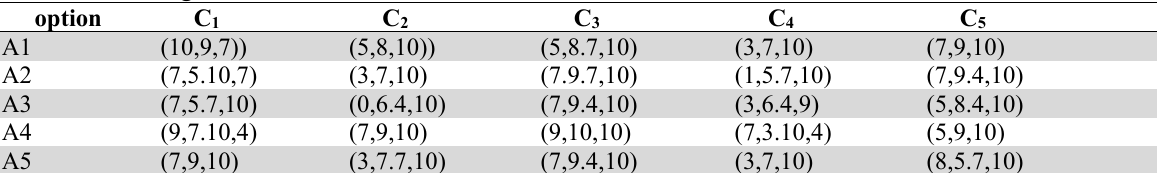
Decision making